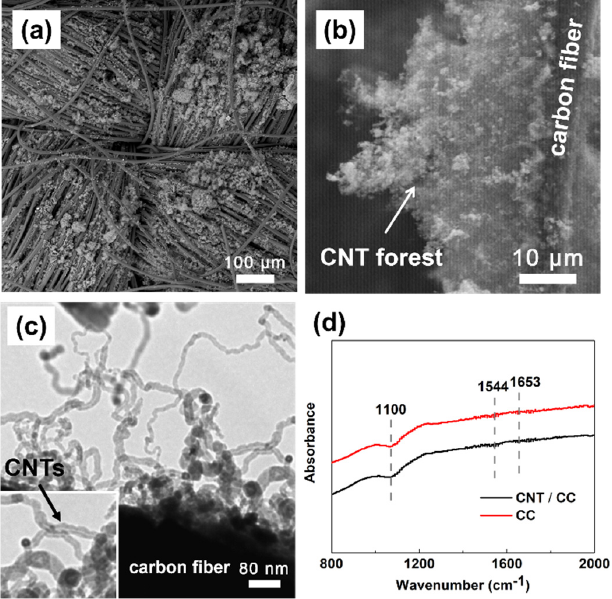
Figure 5. ( a , b ) SEM and ( c ) TEM images of CNT/CC; and ( d ) FTIR spectrum of CC and CNT/CC.